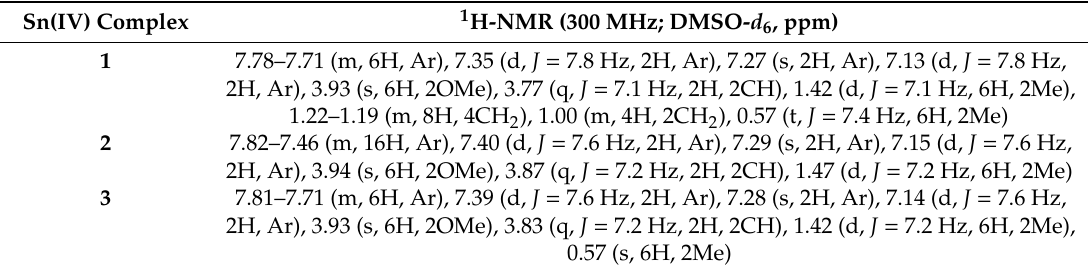
Table 3. 1 H-NMR spectral data for Sn(IV) complexes 1 – 3